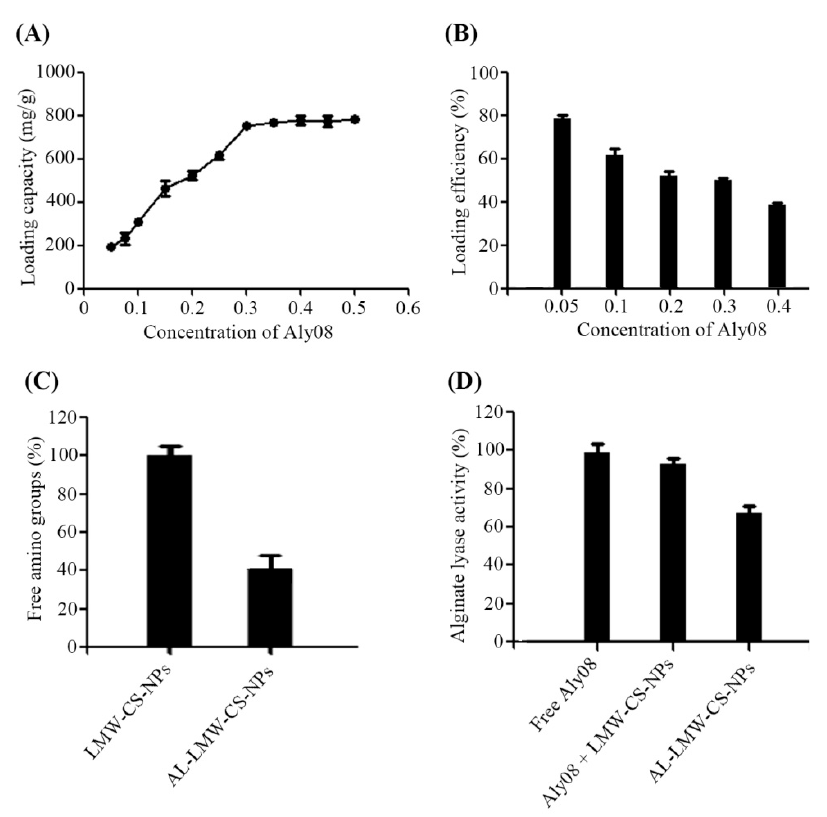
Figure 2. Analysis of alginate lyase immobilized low molecular weight chitosan nanoparticles (AL-LMW-CS-NPs). ( A ) Aly08 loading capacity of AL-LMW-CS-NPs; ( B ) Aly08 loading efficiency of AL-LMW-CS-NPs; ( C ) The % free amino groups of before (LMW-CS-NPs) and after (AL-LMW-CS-NPs) Aly08 loading; ( D ) The % alginate lyase activity of different groups.